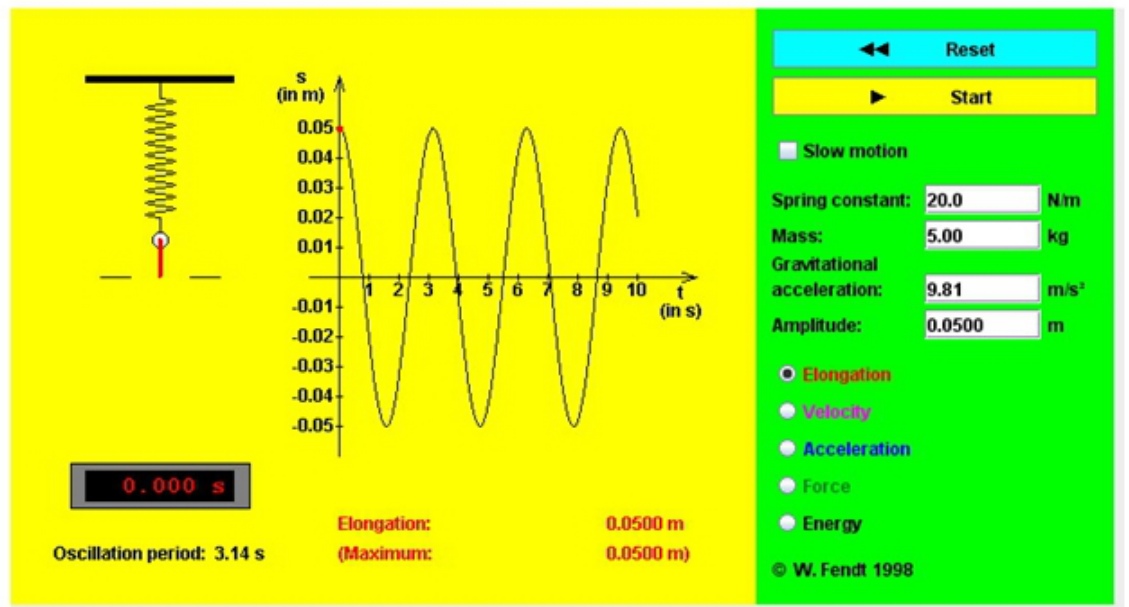
Figure 3. Screenshot from applet No. 3, ‘Spring pendulum’